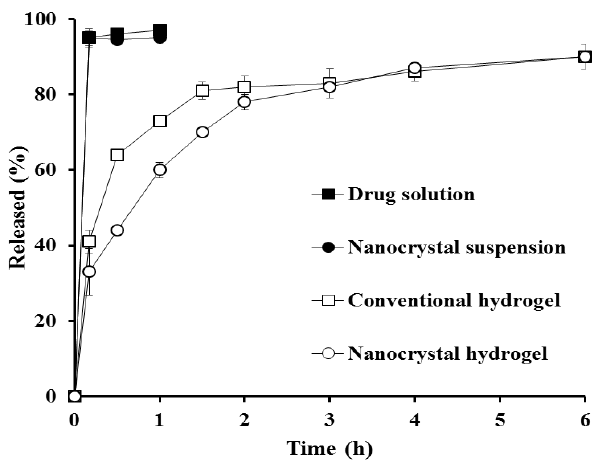
Figure 3. In vitro dissolution profiles of MTK from nanocrystal or conventional formulations under sink condition. Note: The sink condition was continued by adding 0.5% w / v of sodium lauryl sulfate (SLS) to 10 mM phosphate-bu ff ered saline. Released (%) was calculated by dividing the amount of drug dissolved at determined time by the amount of drug loaded, and then multiplying by 100. The data are expressed as mean value ( n = 3) and the SD is expressed as error bar on each